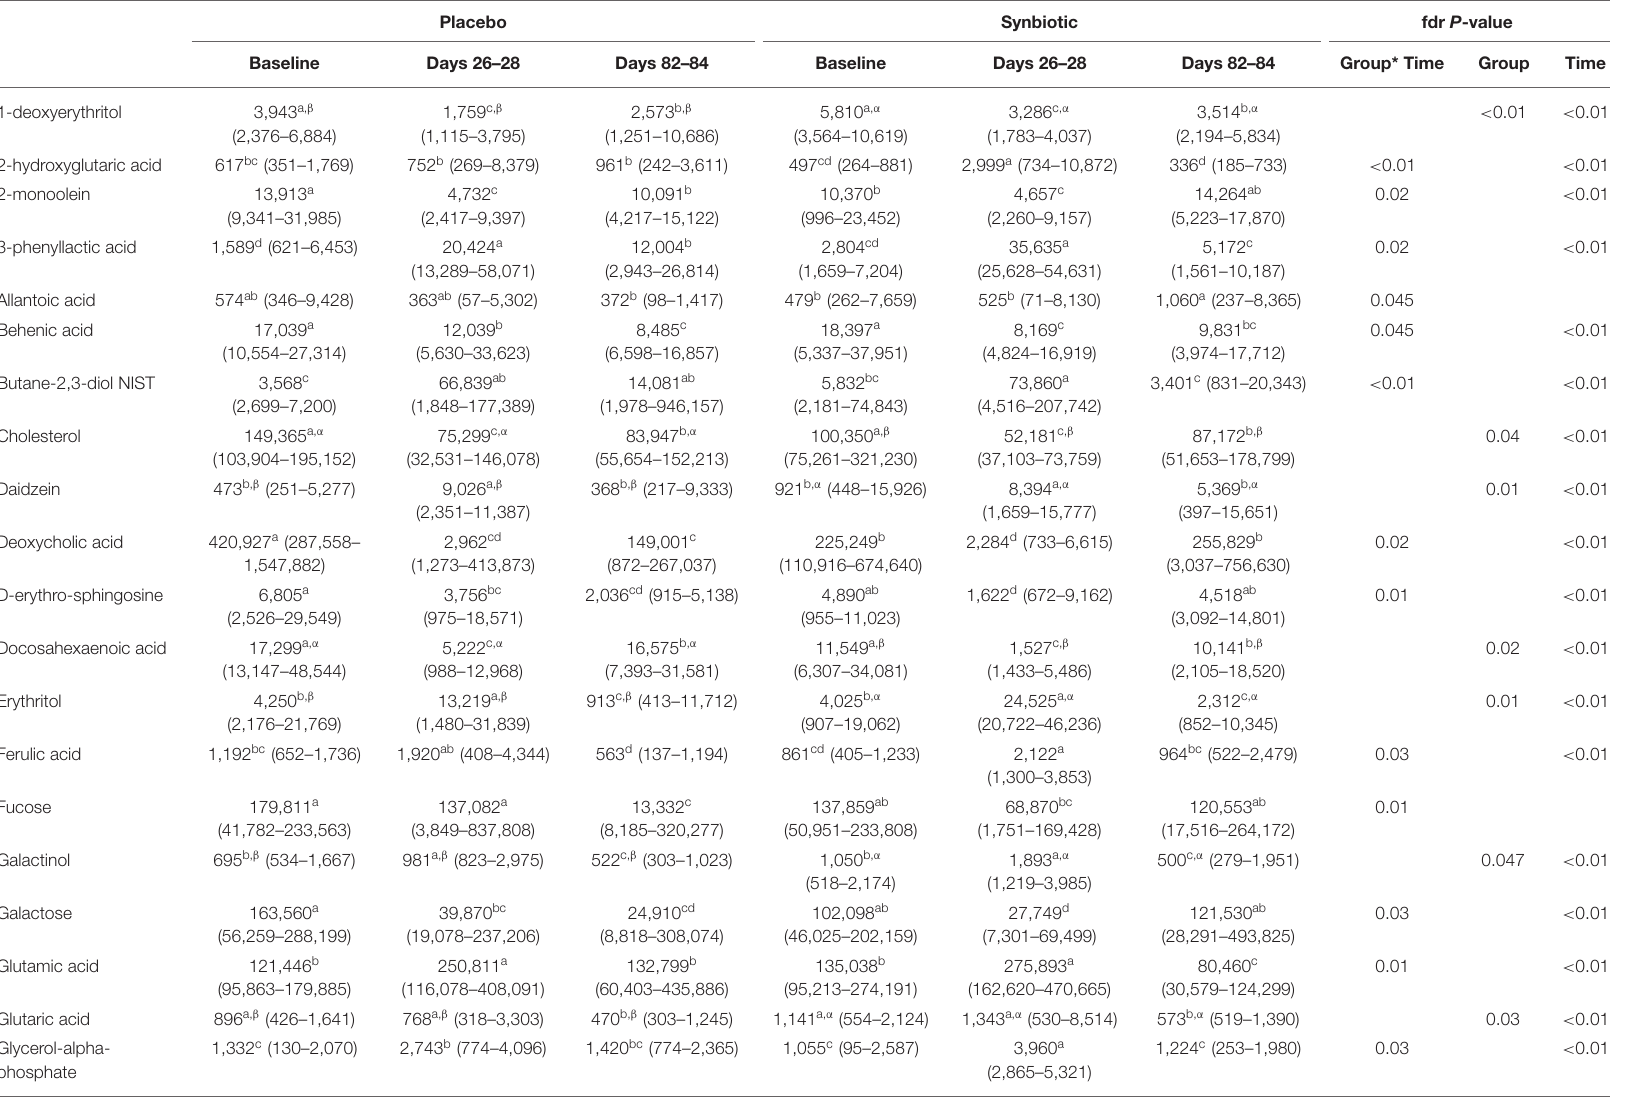
TABLE 3 | Median (range) peak height of fecal metabolites with significant group-by-time interactions or concurrent group and time effects for dogs that received enrofloxacin/metronidazole followed by placebo or synbiotic for 21 days.